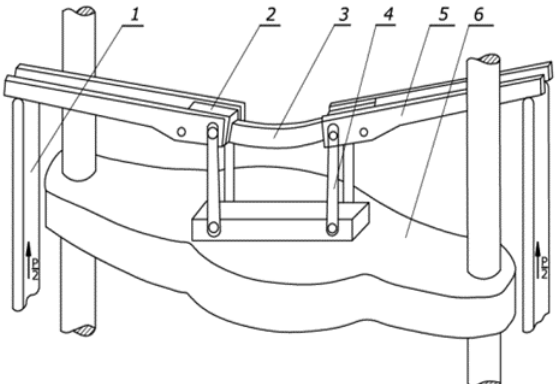
Figure 2. Laboratory four point bending test device [8]: 1- lever, 2 - clamping jaws, 3 - sample, 4 - connector, 5 - bending arm, and 6 - traverse of the testing machine.